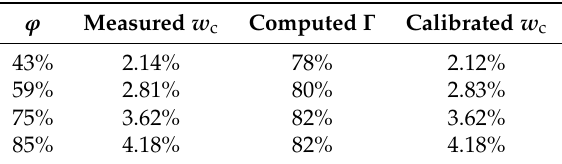
Table 2. Measured versus calibrated mass water content w c of concrete slices at different relative humidities ϕ . ϕ Measured w c Computed Γ Calibrated w c 43%